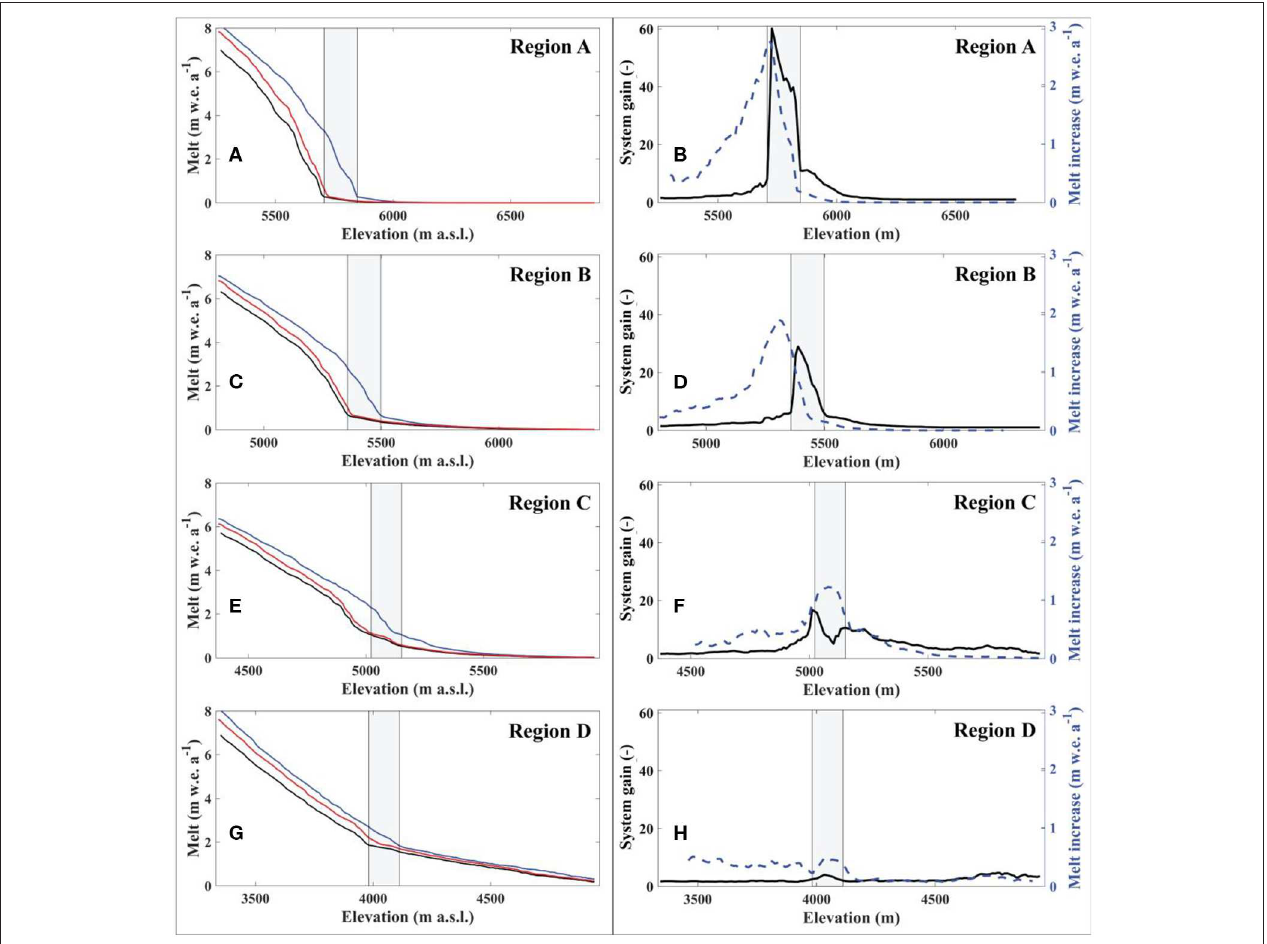
FIGURE 12 | Glacier melt and system gains averaged over 10m elevation bands across the glacier surface. Panels (A,C,E,G) show average melt with 1 T = 0 ◦ C (black line), 1 T = + 1 ◦ C with all trigger switches turned on (blue line), and 1 T = + 1 ◦ C with all three trigger switches turned off (red line). Panels (B,D,F,H) show system gains (black line) and average melt increase (dashed blue line) for 1 T = + 1 ◦ C (with all trigger switches turned on) relative to the control run. The gray rectangle in each plot shows the shift in ELAs due to a temperature forcing of + 1 ◦ C (i.e., the left side of the rectangle is the ELA with 1 T = 0 ◦ C, while the right side of the rectangle is the ELA with 1 T = + 1 ◦